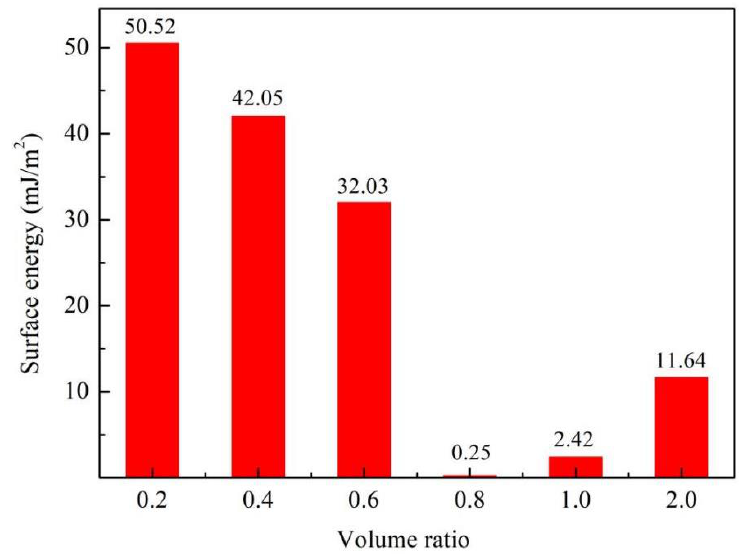
Figure 7. The surface energies of prepared silica aerogels.